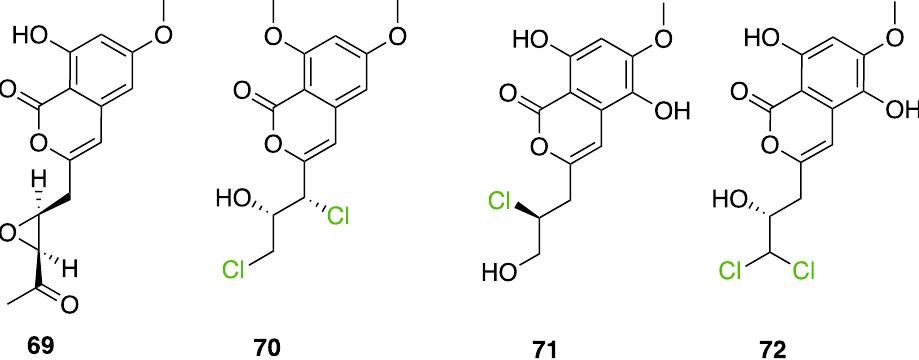
Figure 30. metabolites displaying chlorination on aliphatic chains in the studied cluster 6, peniiso- coumarin C ( 69 ) from Penicillium commune , (9R)-8-methyl-9,11-dichlorodiaportin ( 70 ) from Hamigera fusca, and peniisocoumarin F ( 71 ) and J ( 72 ) from Penicillium commune .